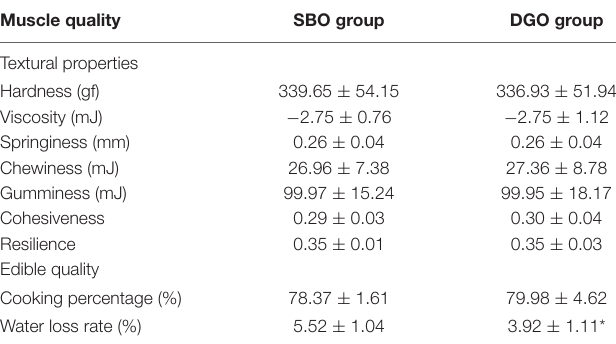
( Table 6 ). Notably, for a specific FA, C18:3n3, C20:2n6,